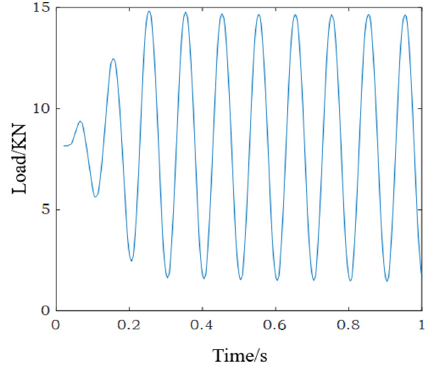
Figure 2. The fatigue load.